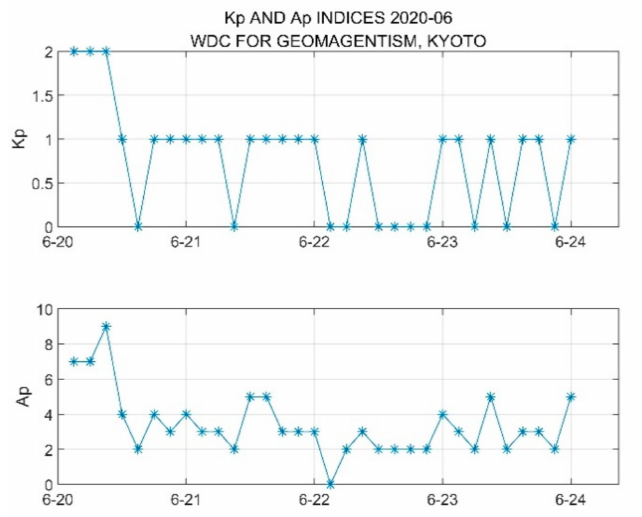
Figure 13. Observation data of Kp from 20 June to 24 June